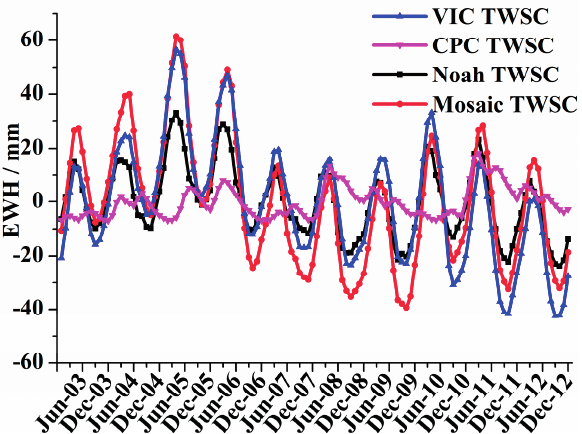
Figure 2. Region-averaged terrestrial water storage changes (TWSC) derived by models, Noah, VIC, Mosaic and